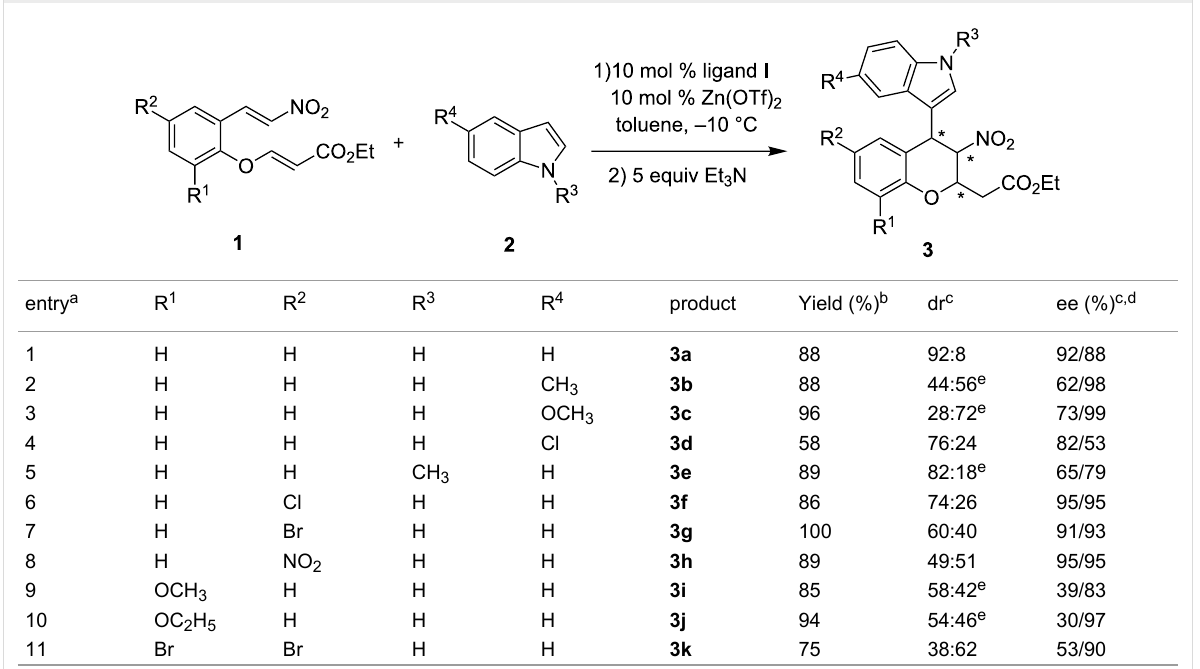
Table 5: Asymmetric tandem Friedel–Crafts alkylation/Michael addition reaction of nitroolefin enoates with